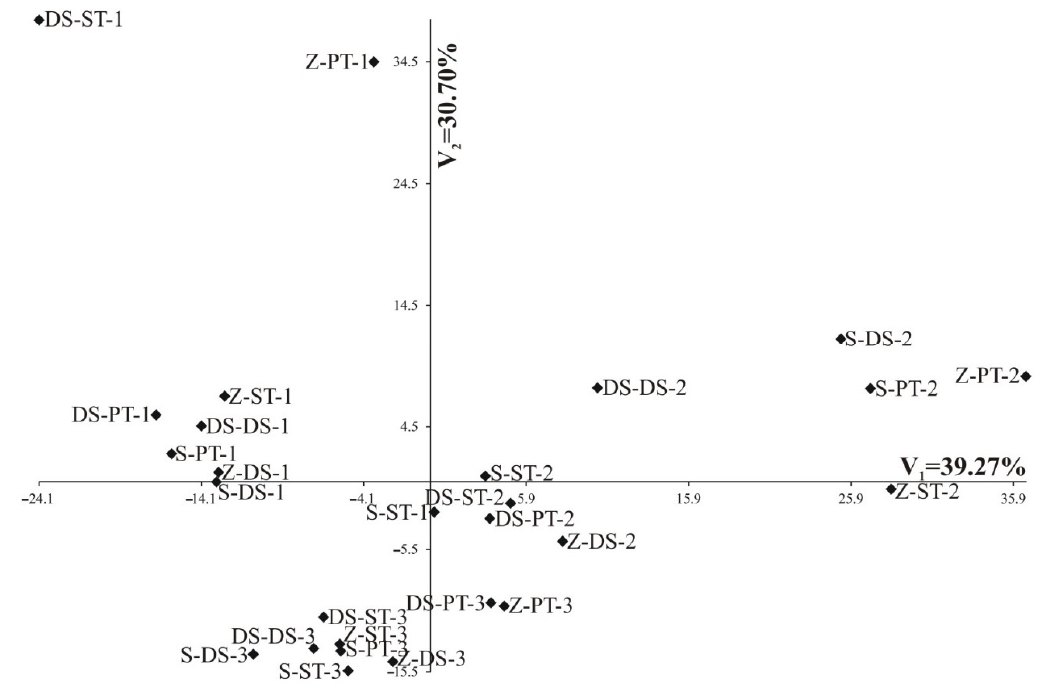
Figure 5. Distribution of the spring wheat treatments in the two first canonical variates at the 4th term (cover crop: Z—zero, S—skimming, DS—direct sowing, ST—simplified tillage, PT—spring ploughing; years: 1—2011, 2—2012, 3—2013).